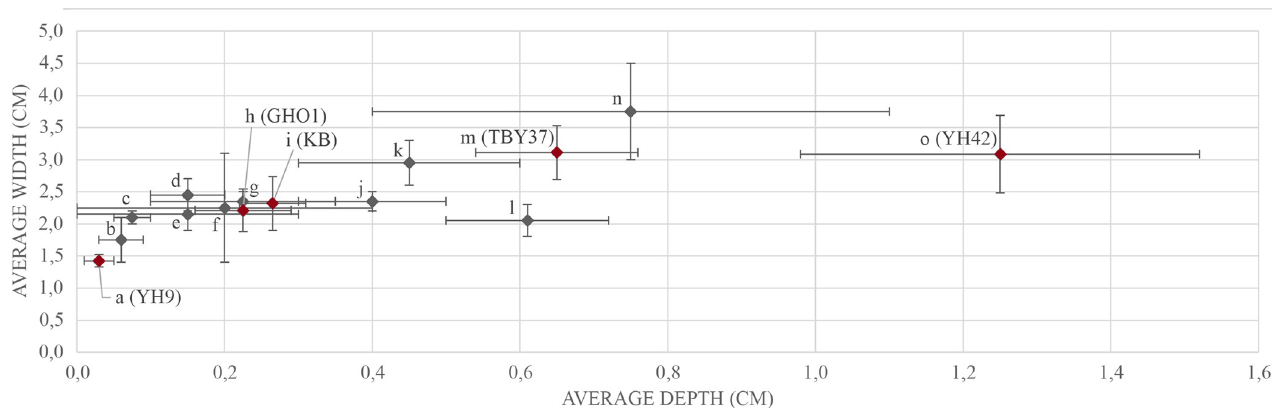
Fig 7. Scatterplot displaying the width and depth of the circumferential depressions. (a) Yehud 9, license B-327/2008 (YH9), loc. 31, reg. no. 31; (b) Qiryat Ata 32, loc 3019, reg. no. 4071; (c) Shiqmim, reg no. 1159.07; (d) Tel Bet Yerah 36, loc. UN 670, reg. no. 176; (e) Tel Bet Yerah 41, loc. UN 029, reg no. 358–50; (f) Giv’at HaOranim, loc 1178, reg. no. 2341; (g) Modi’in 130, loc. 3040, reg. no. 2154; (h) Giv’at HaOranim 1 (GHO1), loc. 4136, reg. no. 3600; (i) Kabri (KB), context unknown; (j) Giv’at HaOranim, loc. 1288, reg. no. 3211; (k) Tel Bet Yerah 42, loc. GB reg. no. 50–7473; (l) Namir Road 46, loc. 121/422 reg. no. 2116; (m) Tel Bet Yerah 37 (TBY37), loc. GB, reg. no. 50–3229; (n) Giv’at HaOranim 2, loc. 1521, reg. no. 4402; (o) Yehud 42, license A-8111/2017 (YH42), loc. 305, reg. no. 2162.